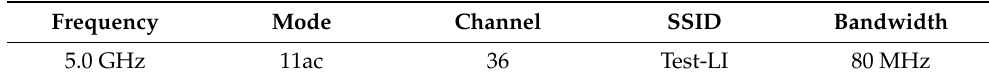
Table 2. Test Access Point Figure 15. Station Power Consumption in web-browsing mode.